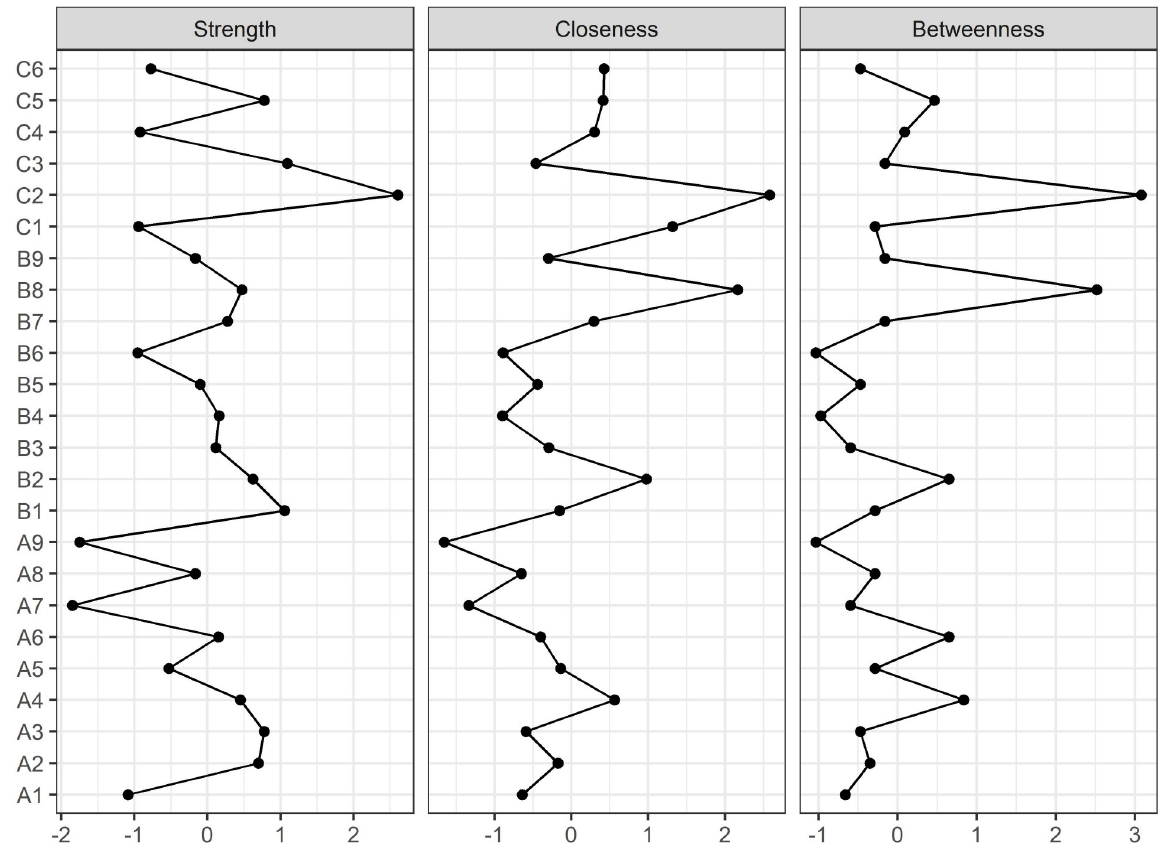
Fig 2. Centrality indices of the network of responses to unusualness due to COVID-19. Centrality indices are shown as standardized z-scores.